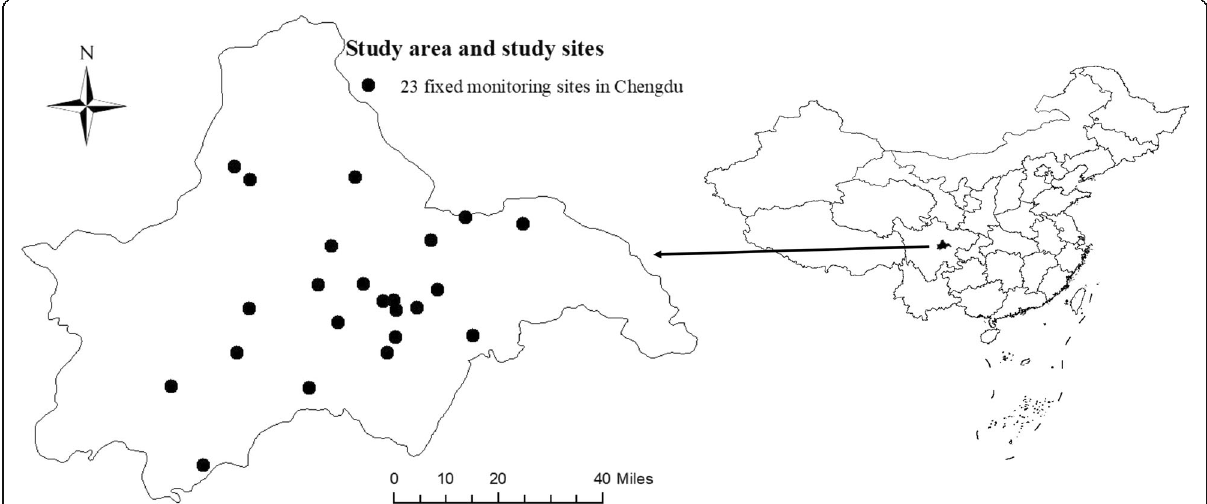
Fig. 1 Location of study area in Chengdu city, southwestern China. The enlarged area on the left depicts the spatial distribution of 23 fixed monitoring sites throughout Chengdu